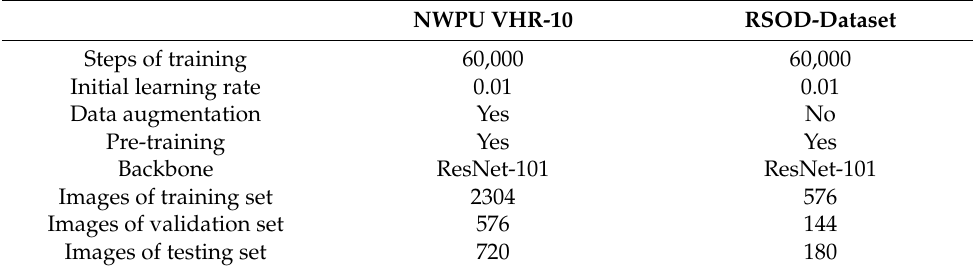
Table 1. Network training parameters and dataset details for Multi-stage FEPN.